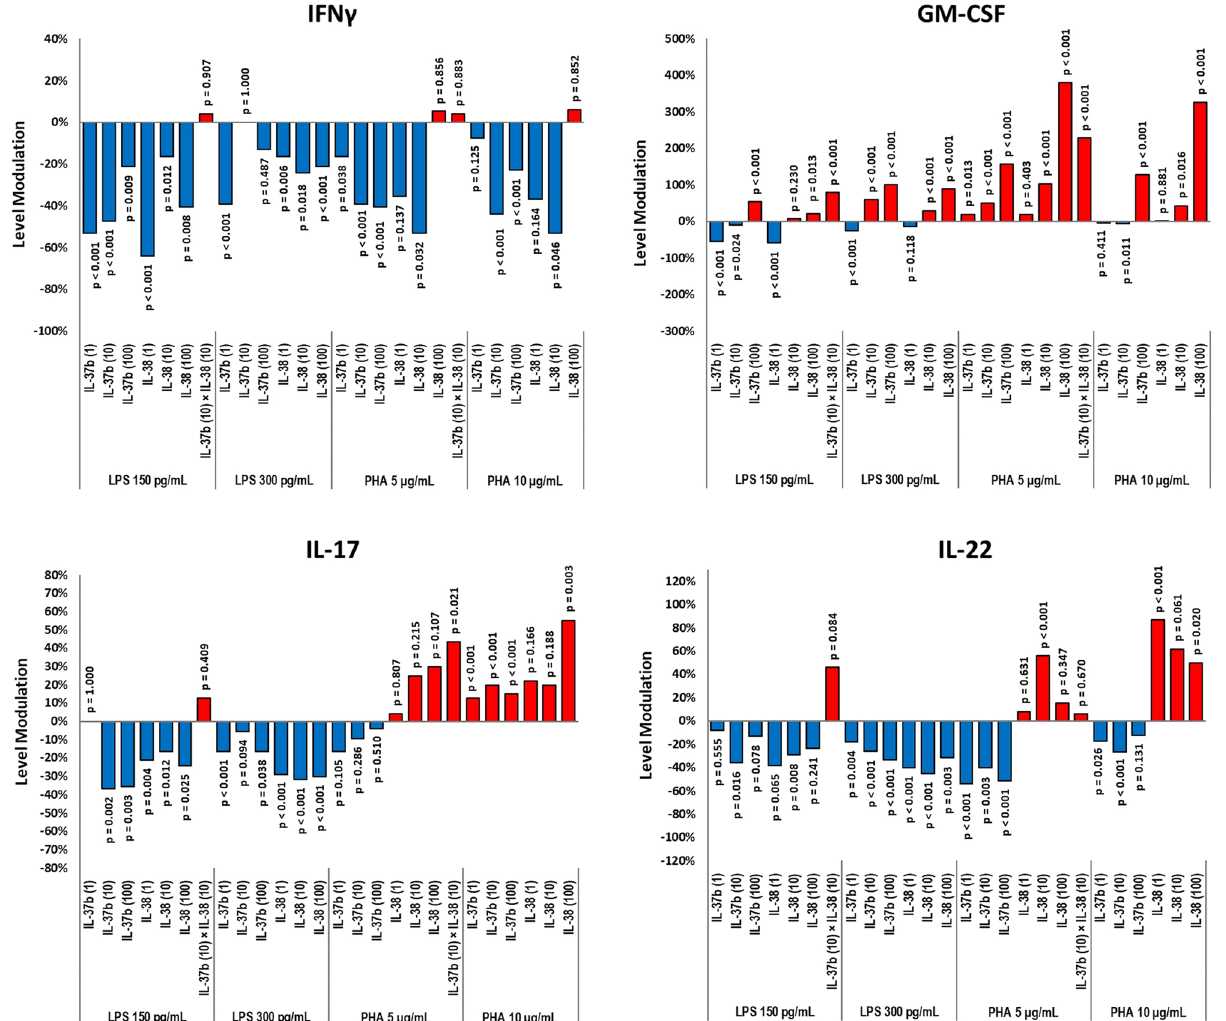
Figure 3. Modulations of secretion of select inflammatory markers (IFNγ, GM-CSF, IL-17 and IL-22) by stimulated PBMCs after treatments with different doses of the plant-produced recombinant IL-37b and IL-38. The effects of the treatments were calculated as percentages (Level Modulations, the “Y” axis) of secretion modulation with its probability value, derived from comparison with the positive control levels (0%, the “X” axis) at the corresponding IAs concentrations for each inflammatory marker